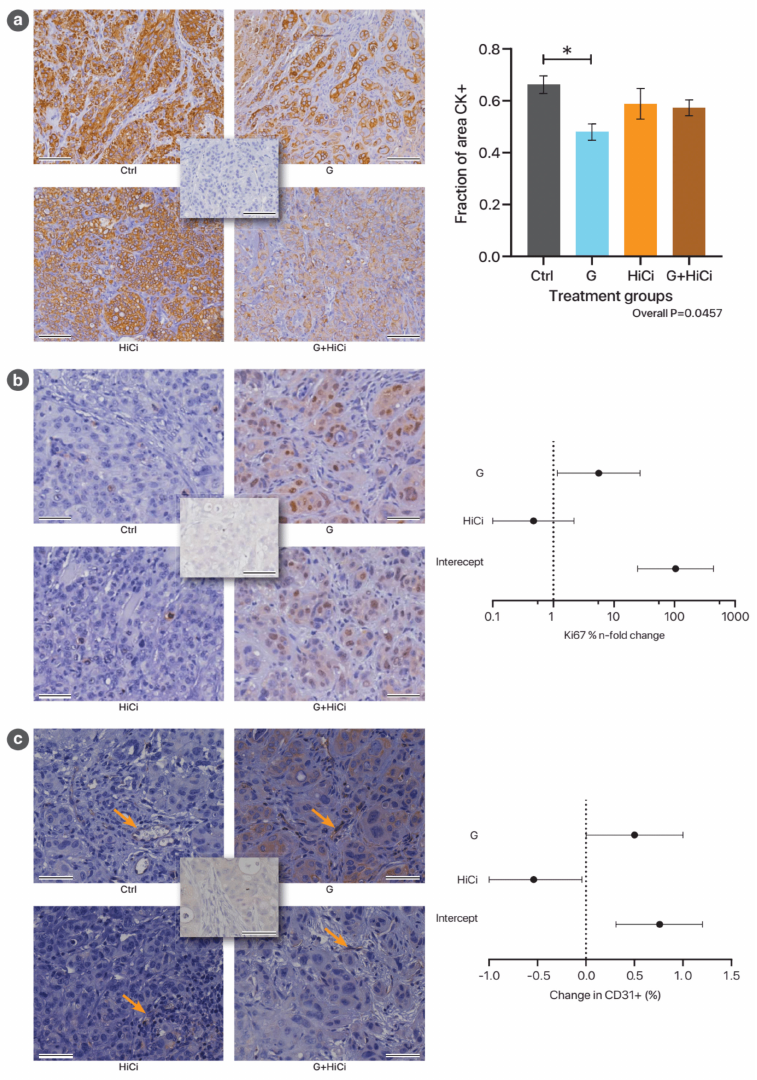
Figure 2. Summary of immunohistochemistry of local recurrent disease. ( a ) Left: Representative images for pan-cytokeratin staining for tissue sections of the recurrent tumour from the different treatment groups. The central image represents the isotype negative control. Images were acquired with 20 × objective. Scale bars: 100 µ m. Right: Column graph representing the relative cancer cell density (pan-cytokeratin staining) of the four treatment groups. * p < 0.05. ( b ) Left: Representative images for Ki67 staining for the different treatment groups. Note that it is the nuclear staining that is important (cytoplasmic background signals are noted in G and G+HiCi groups). The central image represents the isotype negative control. Images were acquired with 20 × objective. Scale bars: 50 µ m. Right: Graphical representation of the linear regression model of Ki67 positivity versus treatments. Model specification may be found in Table A5. ( c ) Left: Representative images for endothelial (CD31) staining of recurrent tumours from the different treatment groups. Selected endothelial cells staining for CD31 are indicated with arrows. The central image represents isotype negative control showing no endothelial staining over an area which appears to contain capillaries. Images acquired with 40 × objective. Scale bars: 50 µ m. Right: Graphical representation of the linear regression model of CD31 staining (as a percentage of tumour cross-sectional area) versus treatments. Model specification may be found in Table